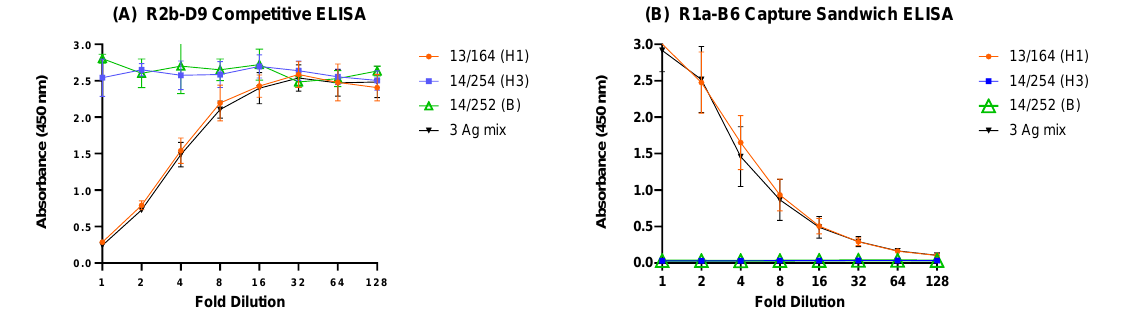
Figure 4. Dose–response of two-fold dilution series of antigen reagents in ( A ) the competitive and ( B ) sandwich ELISA using antigen reagents 13/164 (H1N1)pdm09, 14/254 (H3N2), 14/252 (influenza B) as well as a mix of all three reagents.